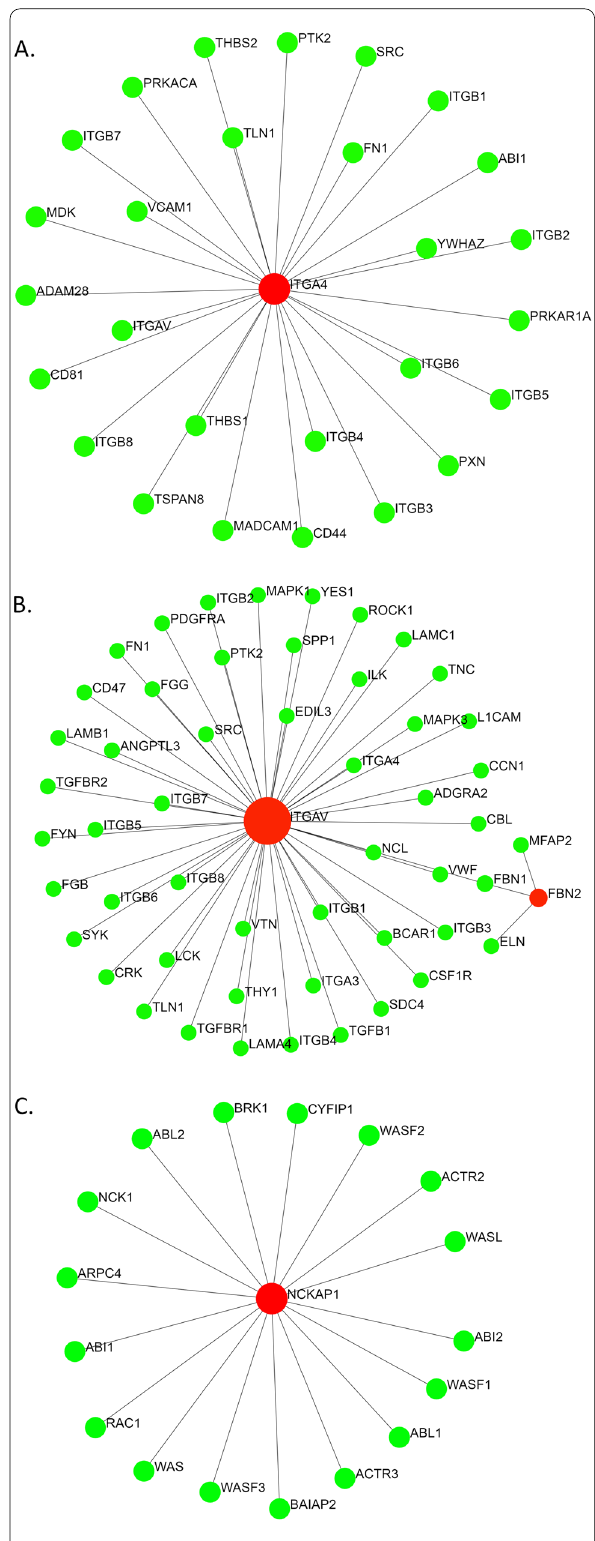
Fig. 4 Interactions of ITGA4 ( A ), ITGAV ( B ) and NCKAP1 ( C ) with the known AMC and DA-associated proteins. Only the interactions with a high confidence score and experimental evidences are shown in the figure. AMC and DA-associated gene-encoded proteins along with ITGAV, ITGA4, and NCKAP1 are shown in red and the other interacting proteins are shown in